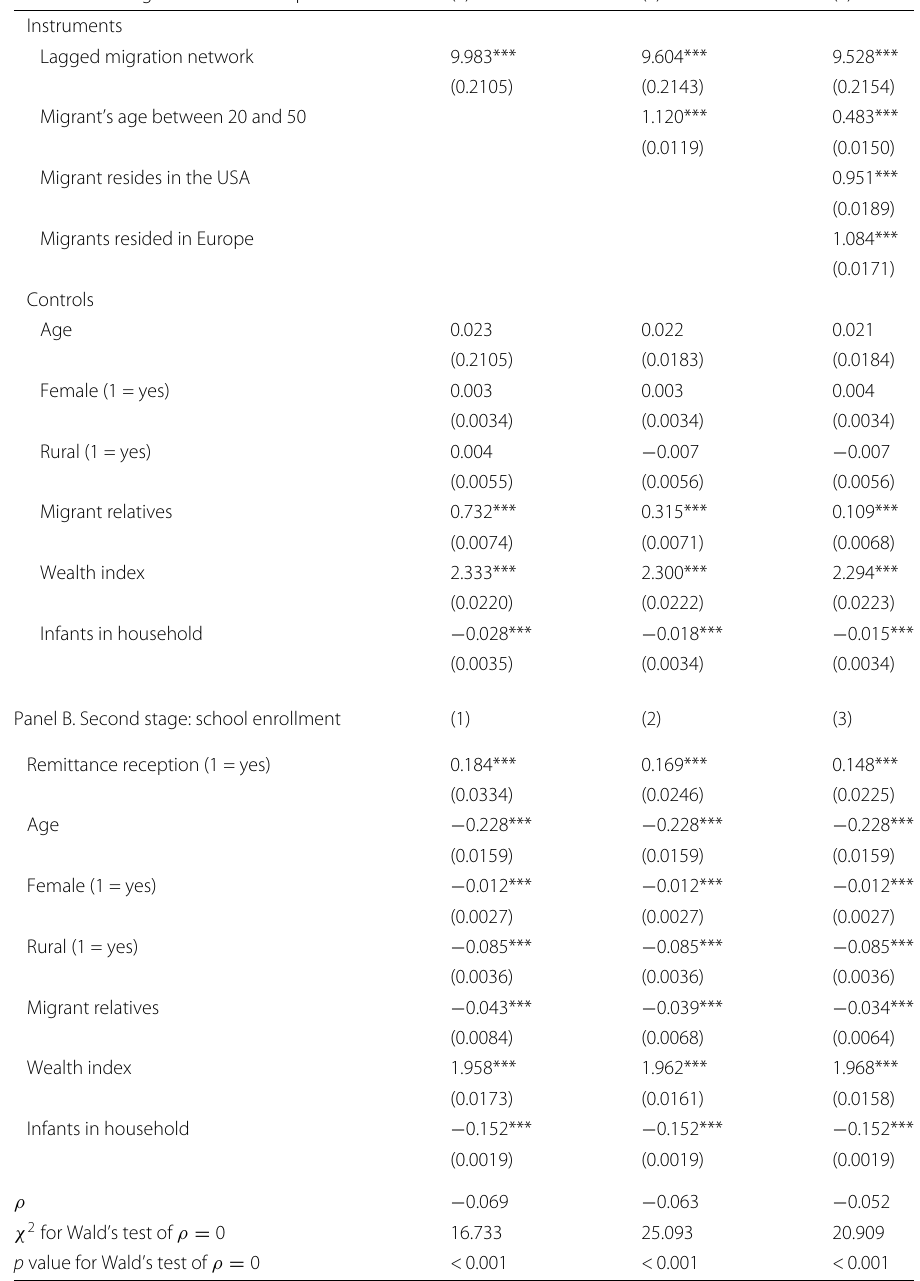
Table 8 Bivariate probit results: probit coefficients for school enrollment and remittance reception Panel A. First stage: remittance